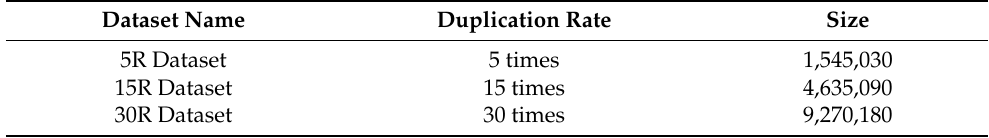
Table 2. Characteristics of the duplicated